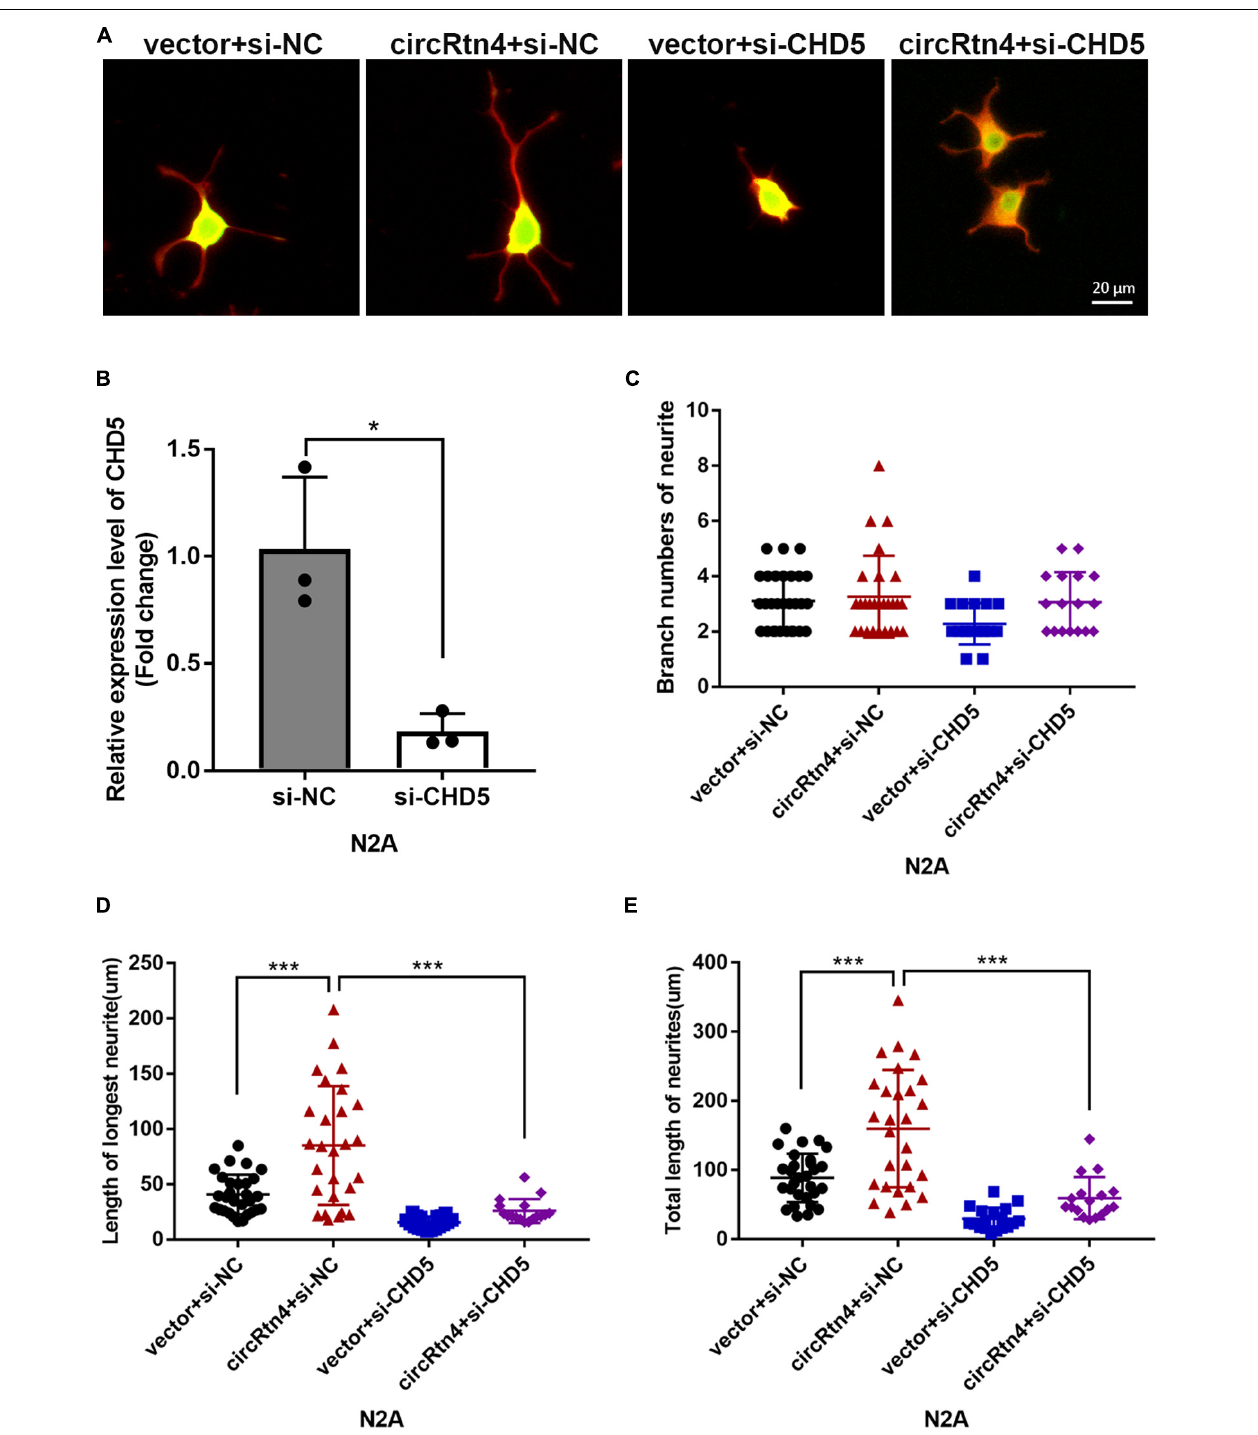
FIGURE 8 | CHD5 reversed the neurite growth promotion mediated by circRtn4. (A) After transfected with vector + si-NC, circRtn4 + si-NC, vector + si-CHD5 and circRtn4 + si-CHD5, N2a cells were fixed and immunostained with anti- β -tubulin III antibody and captured by a Zeiss LSM 710 confocal microscope with a 20 × objective (Red, β -tubulin III; Green, GFP). N2a were cotransfected with 100 nM siRNA and 500 ng/ml pcDNA3.1 vector. (B) The knockdown efficiency of CHD5 was determined by qRT-PCR ( n = 3). (C–E) The branch numbers of neurite, the length of longest neurite and total length of neurites were quantified by Image-Pro Plus software. The results were shown as the mean ± SD (* p < 0.05, and *** p < 0.001).